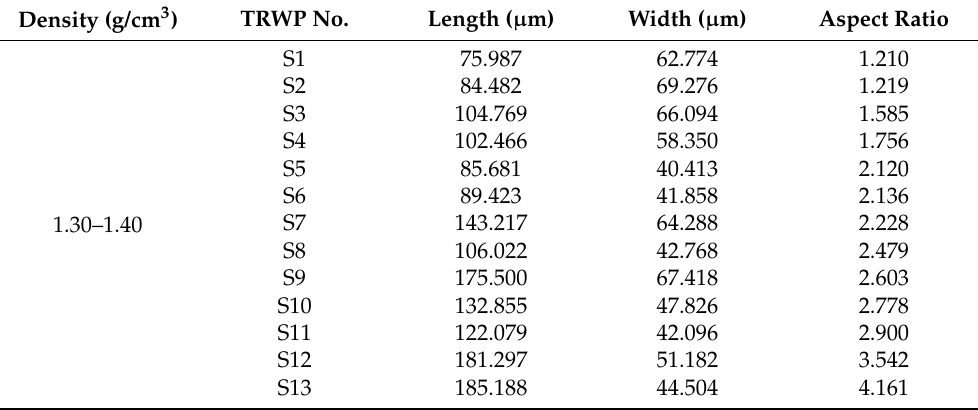
Table 4. Aspect ratios of TRWPs separated from the RD4 sample (63–106 µ m). Density (g/cm 3 ) TRWP No. Width ( µ